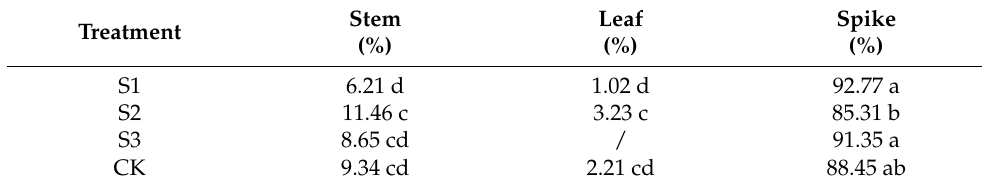
Table 9. Distribution of 13 C in each organ of the plant under different source bank treatments at wheat